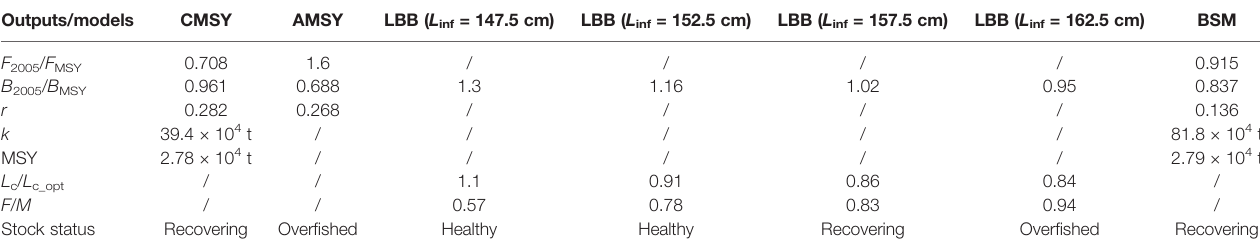
TABLE 2 | Main outputs of the four models used in this study for the southern Atlantic albacore ( Thunnus alalunga ) fi shery.